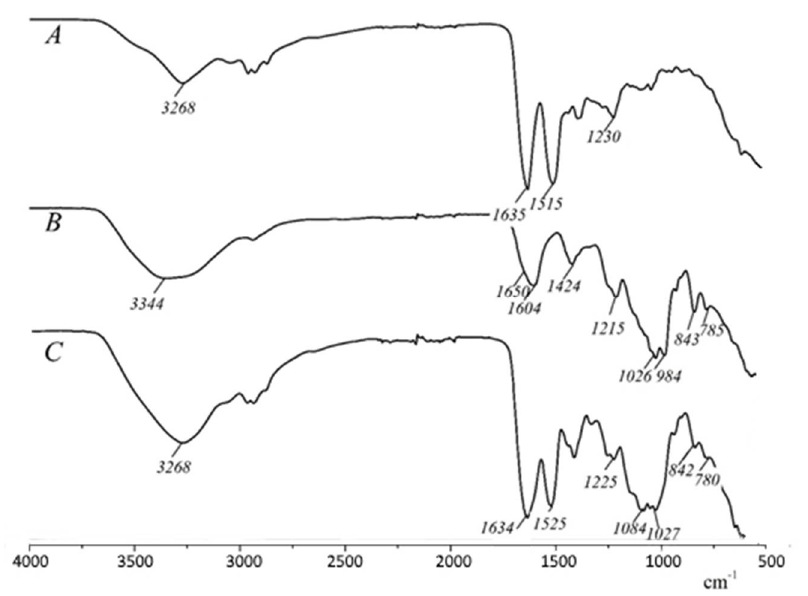
Figure 4. FT-IR spectra of nisin ( A ), ulvan ( B ) and ulvan–nisin complex prepared at pH 6.0 ( C ). Differential scanning calorimetry (DSC) and thermogravimetric analysis (TGA) were used to investigate the thermal properties of nisin, ulvan and nisin-loaded ulvan particles.